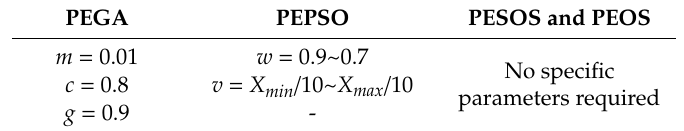
Table 2. Specific parameters for each algorithm, with N P = 10, 20, or 50, and M iter = 10,000 or 20,000. PEGA PEPSO PESOS and PEOS m = 0.01 w = 0.9~0.7 No specific c = 0.8 v = X min / 10~ X max / 10 parameters required g = 0.9